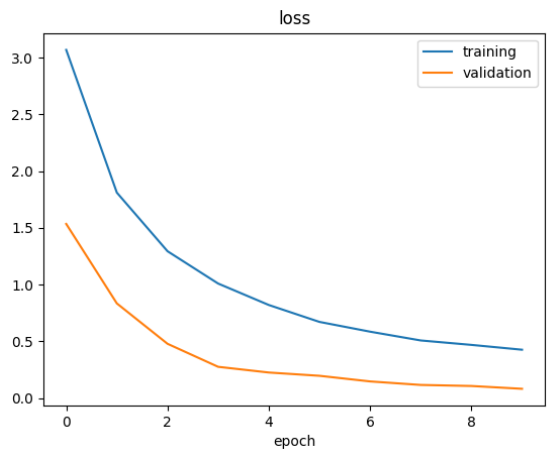
Fig. 13. Plot of training set loss and validation set loss Fig. 13 is a curve showing the categorical cross-entropy loss